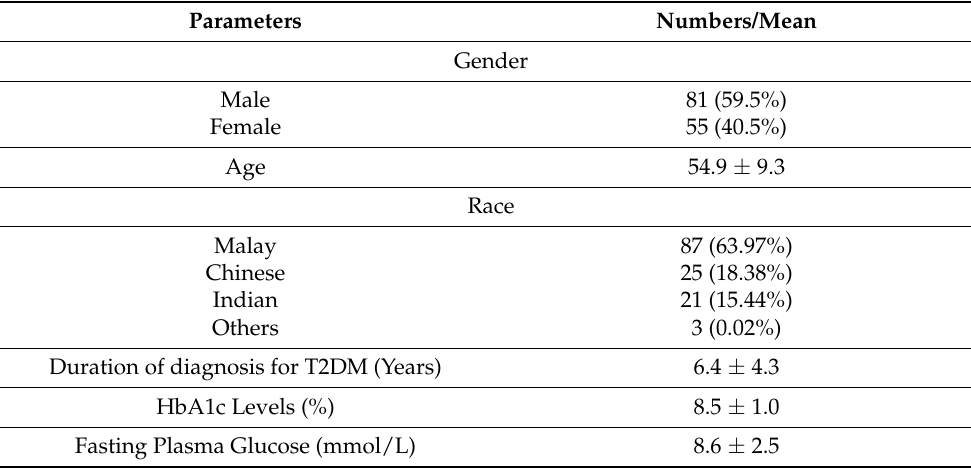
Table 4. Sociodemographic of participants identified ( n =